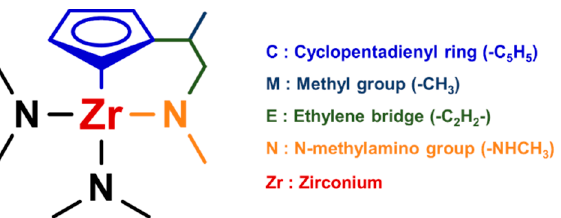
Figure 2. Molecular structure of CMEN-Zr employed in the plasma-enhanced atomic layer deposition of zirconium oxide thin films.